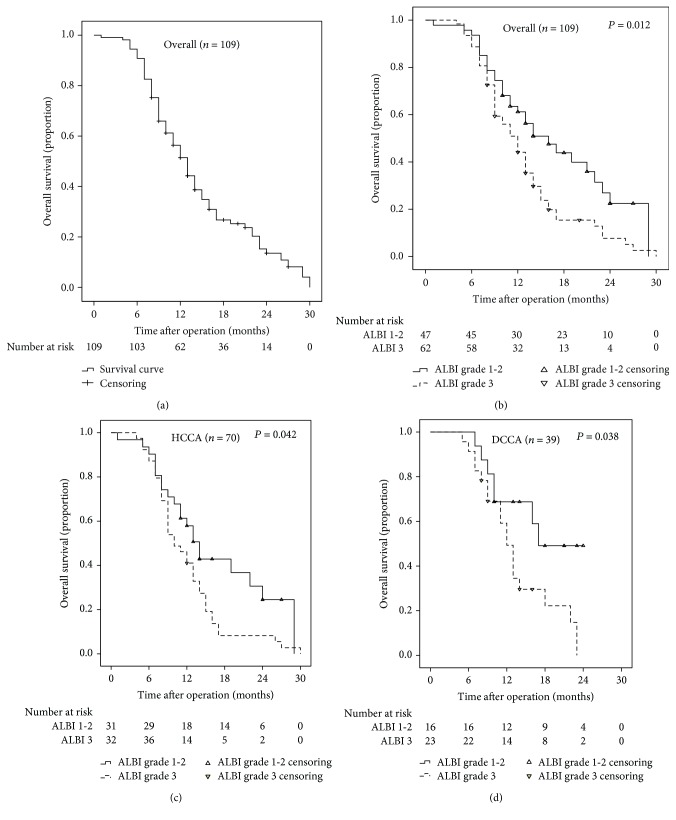
The survival curves of unresectable EHC patients. The whole cohort (a), stratified according to ALBI grade in the whole cohort (b), stratified according to ALBI grade in the HCCA subgroup (c), and stratified according to ALBI grade in the DCCA subgroup (d).